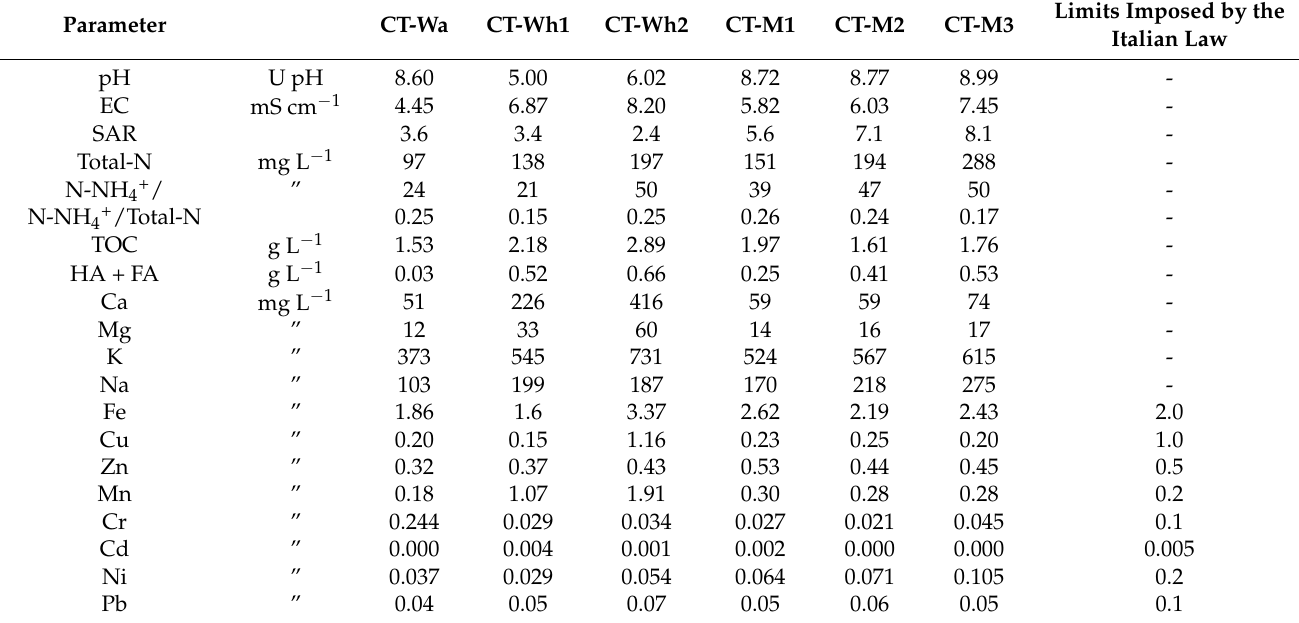
Table 4. Chemical and physical features of the final CTs and concentration limits of total heavy metals imposed by the Italian law for wastewater reuse (Decree No. 185, 12/06/2003, Ministry for Environment).